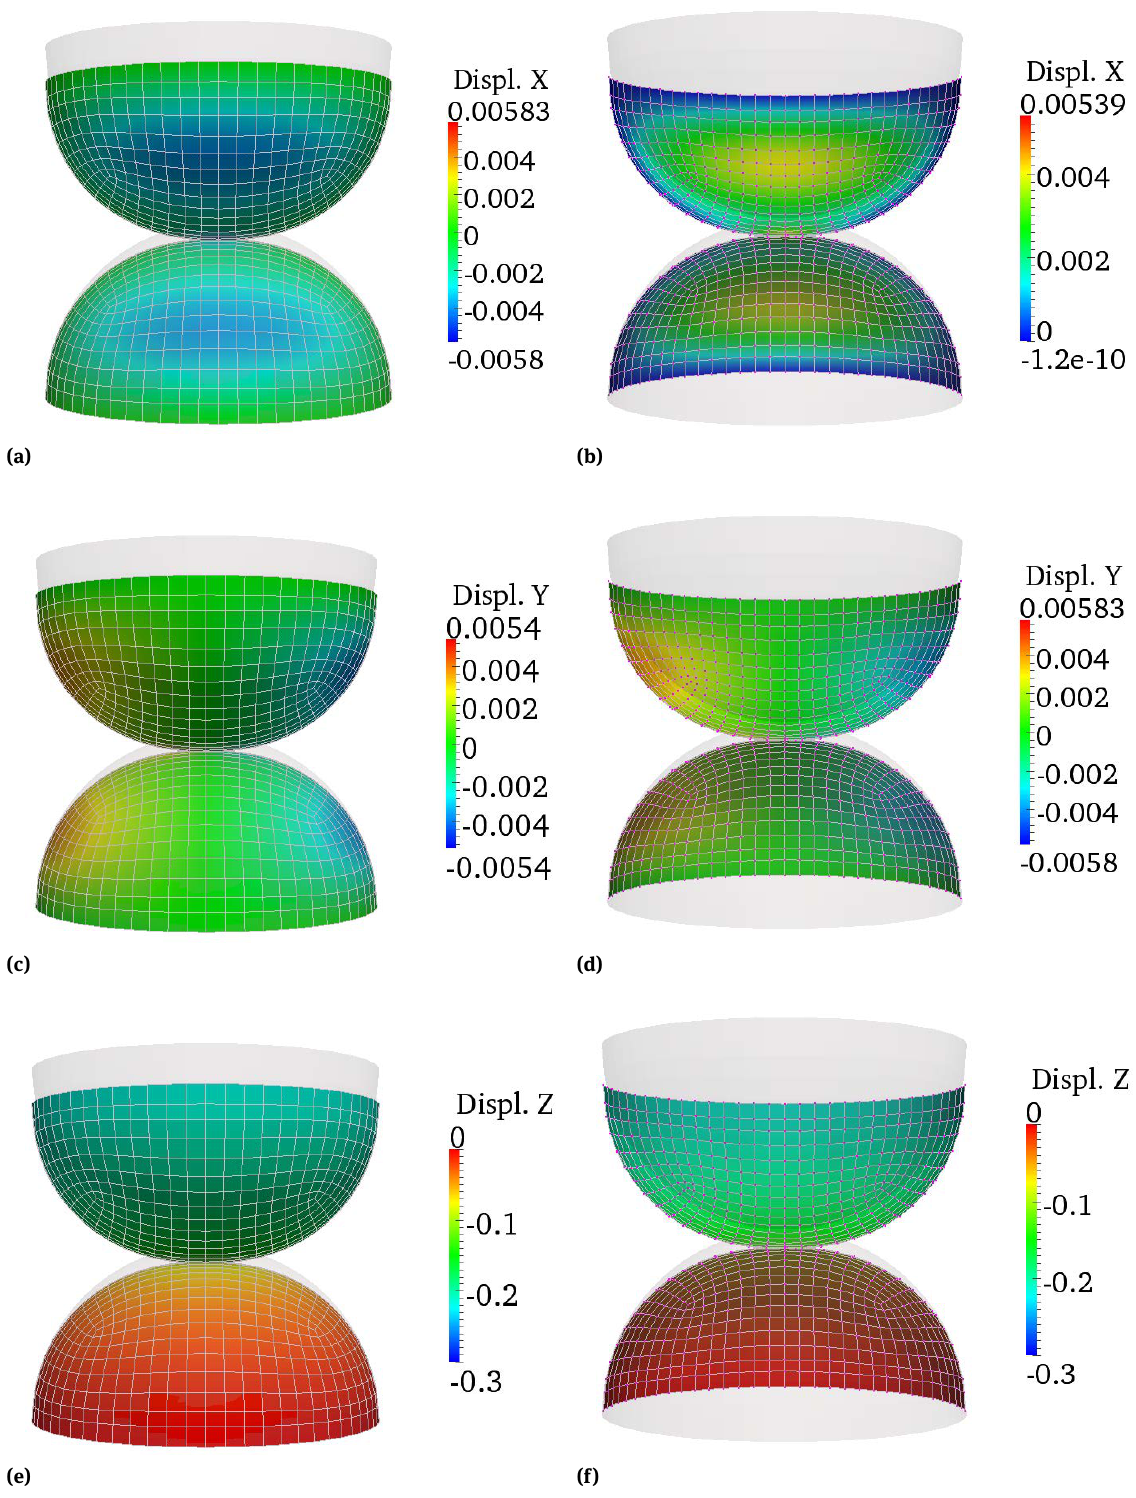
Figure 16: Hemispheres in normal contact: undeformed and deformed shape and displacement contours for step